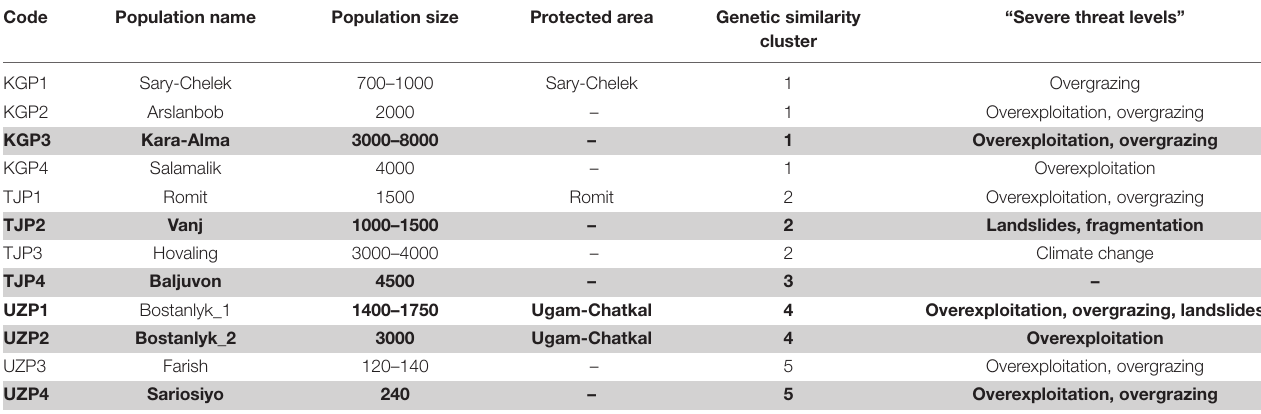
FIGURE 6 | Genetic clusters and priority population for conservation (named in blue) of wild common walnut, superimposed on the expert-corrected modeled distribution area of the species. The colors of the pie charts refer to the membership of the population to one of the five genetic clusters identified by STRUCTURE ( K = 5) and the proportion of the pie charts sectors to the relative number of individuals assigned. TABLE 7 | Summary of “severe threat levels” and related threats, genetic similarity, population size, and protected areas of 12 wild Juglans regia L.